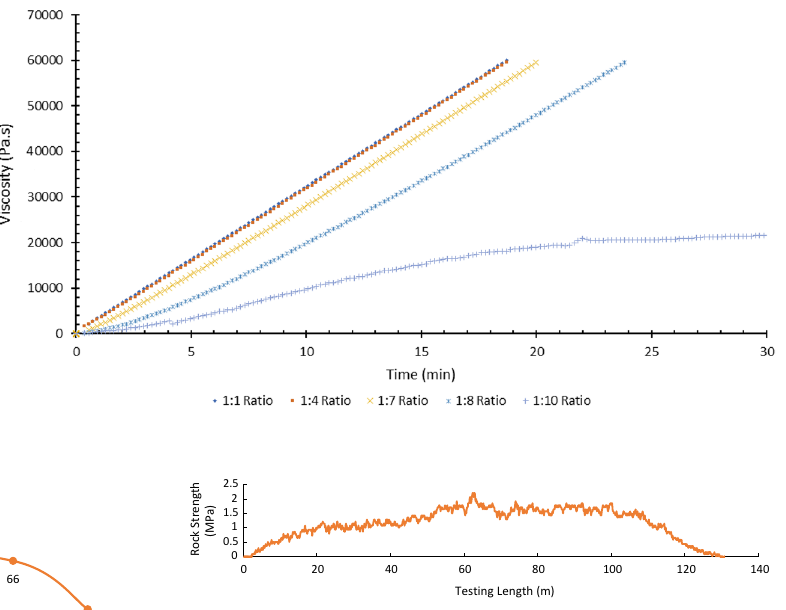
Fig. 10 Rheology of the reac- tive polymer at 0.01 RPM